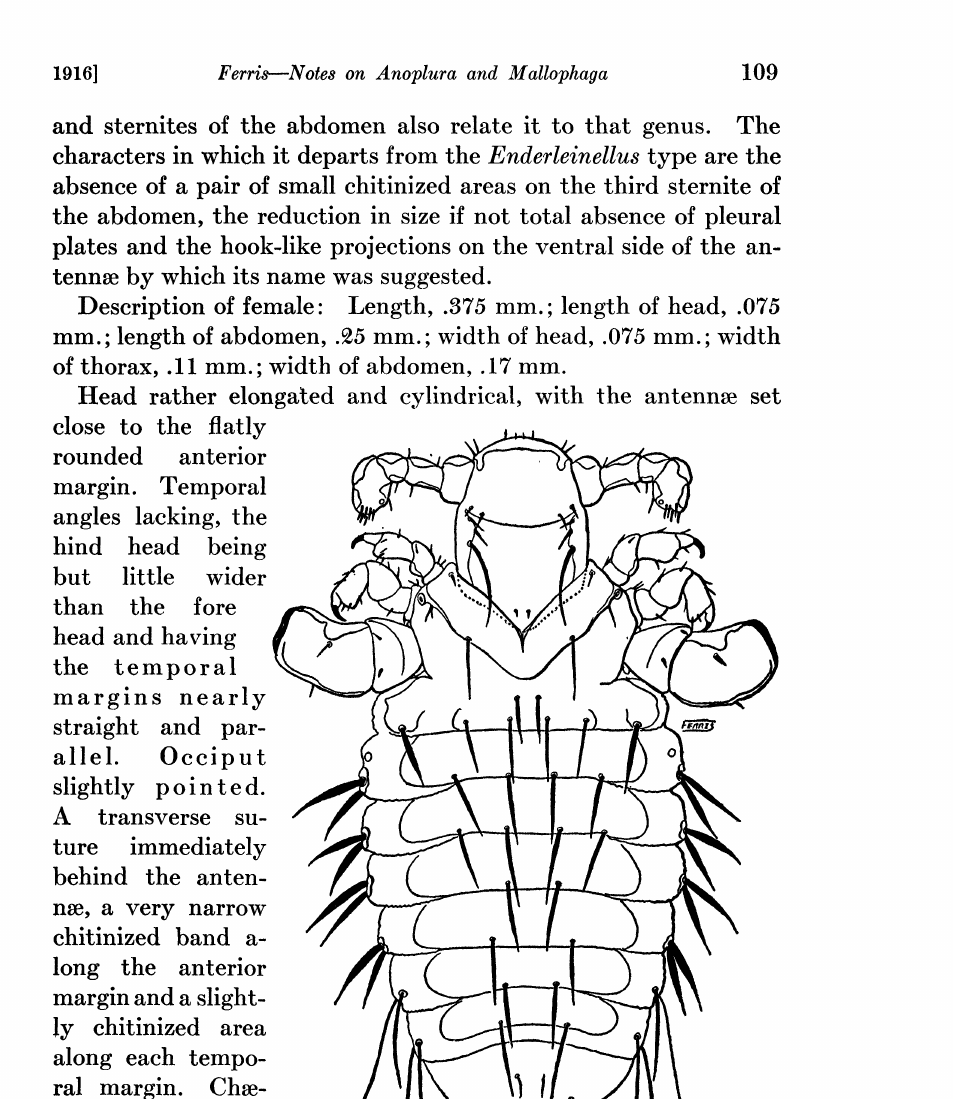
Fig. 6. Enderleinellus uncinaus sp. nov.; dorsal side small hairs on each of